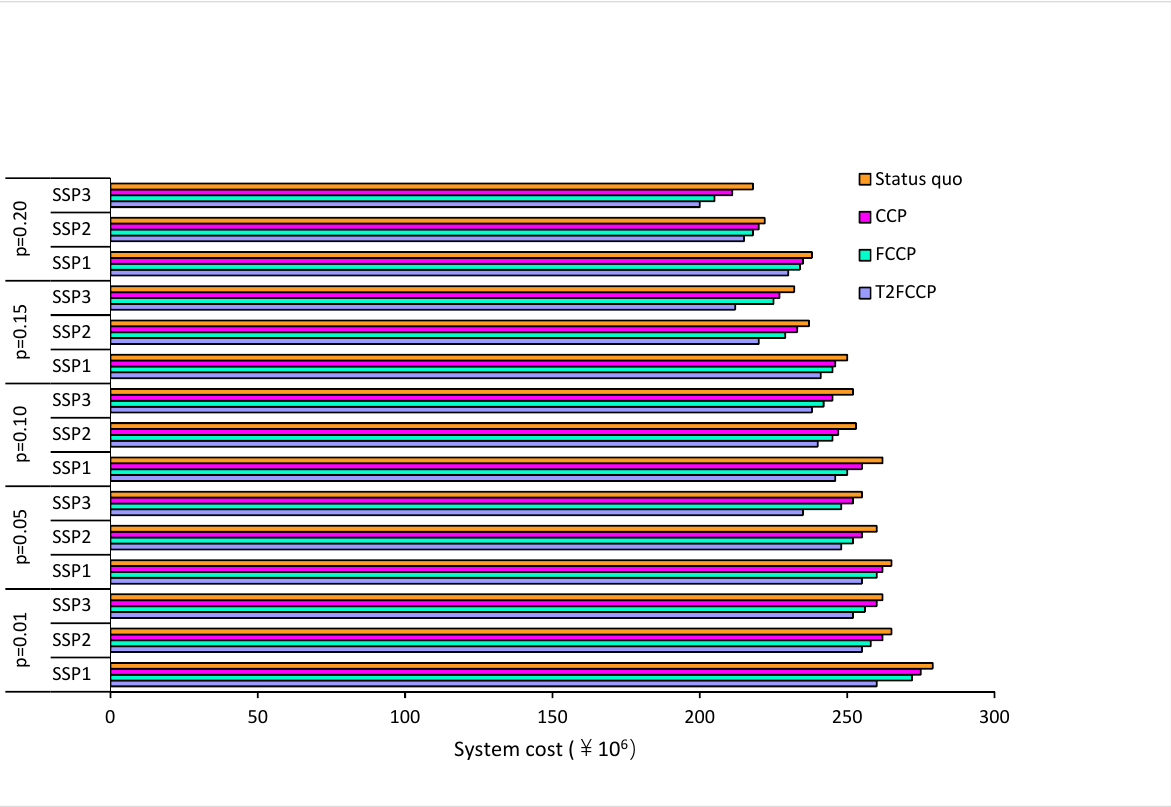
Figure 6. System cost calculated by the CCP, FCCP, T2FCCP model and status quo in SSPs under different probabilities.